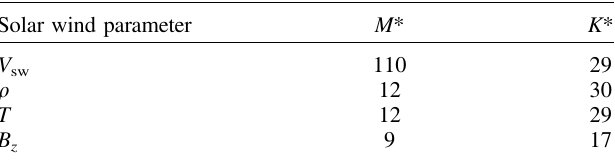
Table A.1. Optimal M * and K * values found for fi lling the gaps in the time